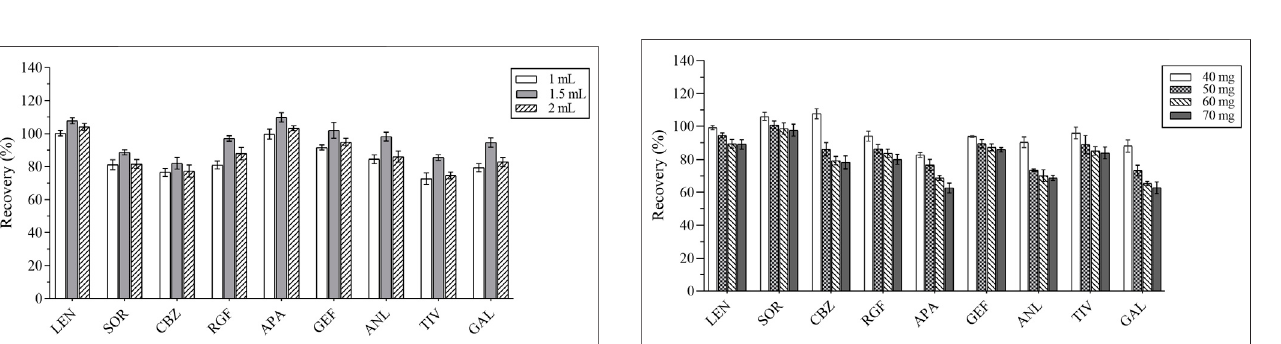
FIGURE 6 | The recovery results of all analytes with different amounts of PSA.